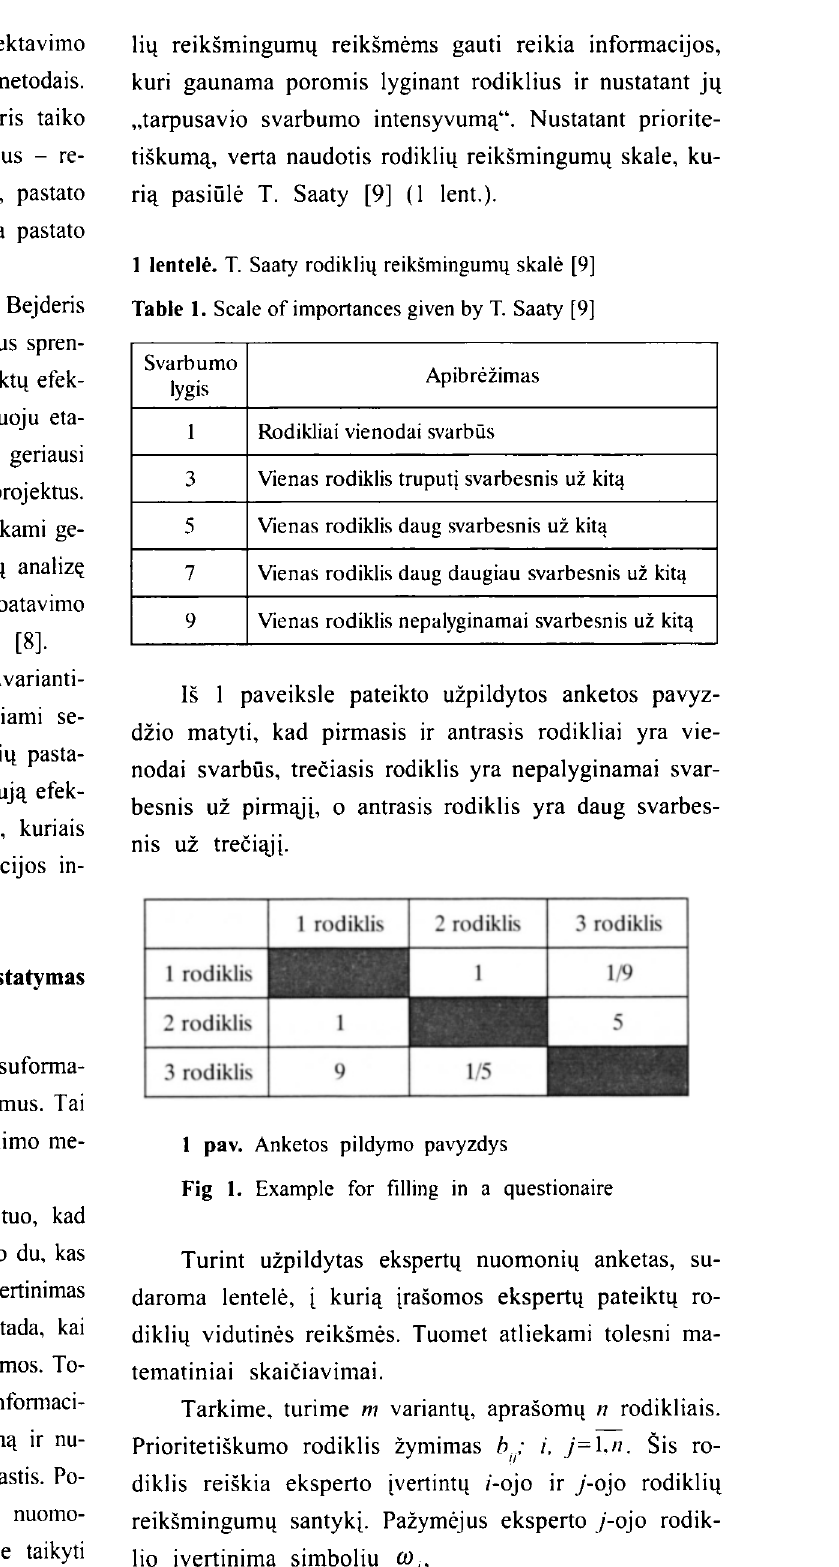
Fig 1. Example for filling in a questionaire Turint uzpildytas ekspert4 nuomoni4 anketas, su daroma lentele, i kuriq irasomos ekspert4 pateikt4 ro dikli4 vidutines reiksmes. Tuomet atliekami tolesni ma tematiniai